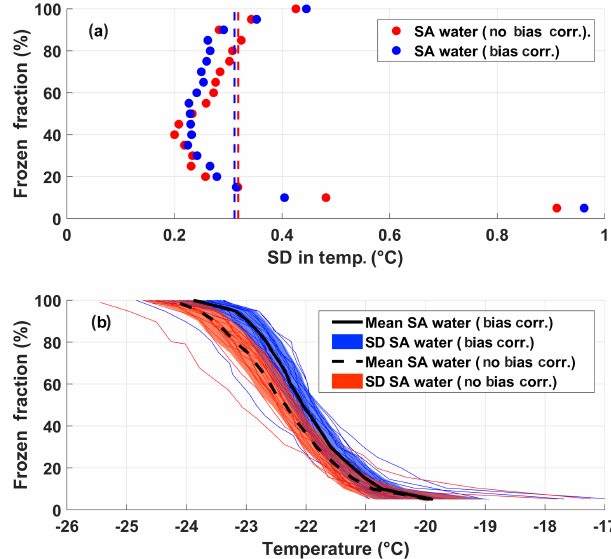
Figure 6. (a) FF and the corresponding standard deviation (SD) of the freezing temperatures from the 20 SA experiments with and without the bias correction, shown as blue and red dots, respectively. The red and blue dashed lines represent the standard deviations in temperature averaged over all FF values without and with the bias correction, respectively. (b) The FF of the 20 SA water experiments as a function of temperature with and without the bias correction (thin blue and red lines, respectively). The colored shading repre- sents the standard deviations of the SA water from the mean freez- ing temperature with (solid black line) and without (black dashed line) the bias